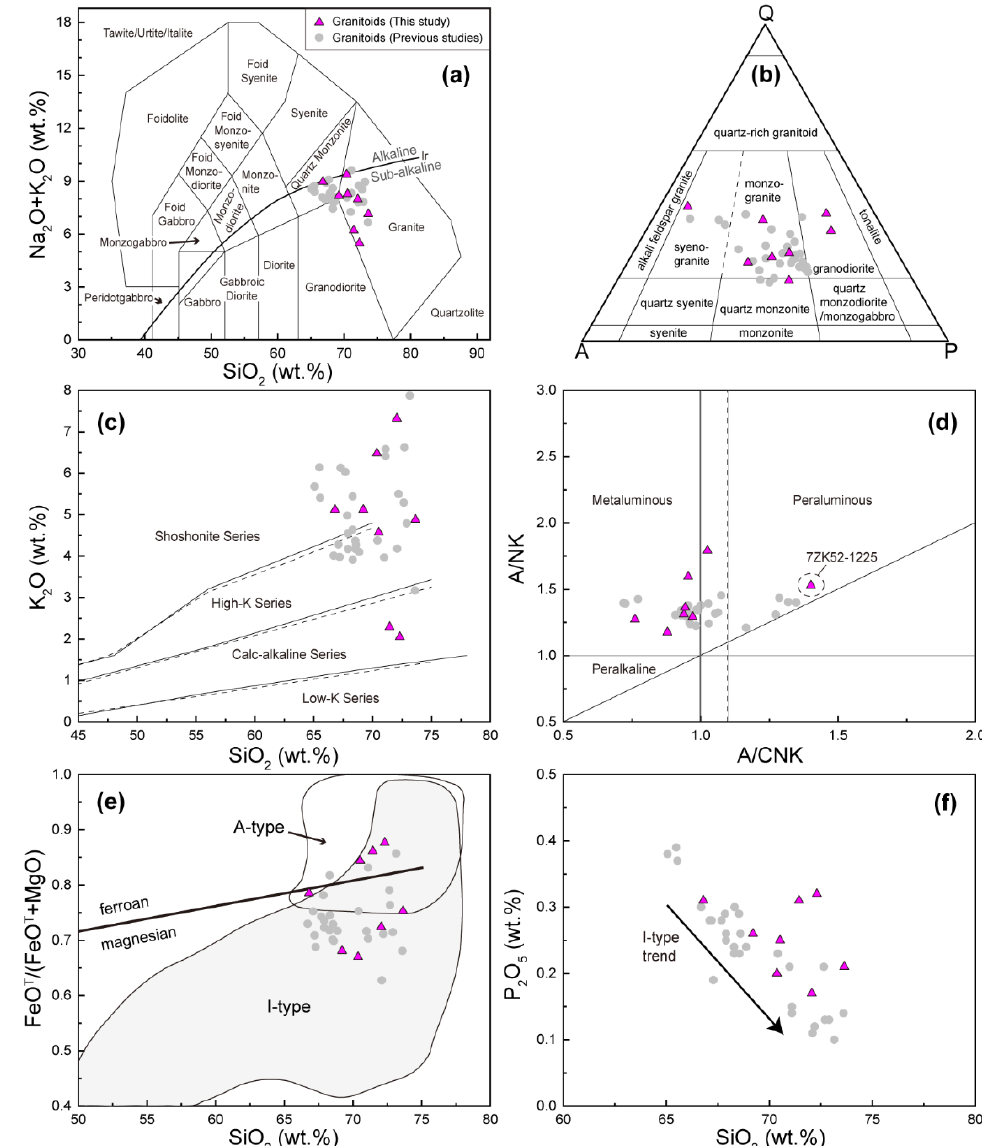
Figure 5. Compositional discrimination diagrams of the Hongniu Hongshan granitoids. ( a ) TAS diagram; ( b ) Q-A-P diagram; ( c ) K 2 O vs. SiO 2 diagram; and ( d ) A/NK vs. A/CNK diagram for classification of rock series. ( e ) FeO T /(FeO T + MgO) vs. SiO 2 diagram and ( f ) P 2 O 5 vs. SiO 2 diagram for classification of genetic types. Gray dots show the Hongniu-Hongshan granitoids reported by previous studies [13,15,17,39]. See Tables S1 and S4 in the Supplementary Materials for data in this figure. In the chondrite-normalized rare earth element (REE) diagram [40], these samples show significant enrichment of light rare earth elements (LREEs) compared with heavy rare earth elements (HREEs; Figure 6a) with LREE/HREE = 18.3 – 24.3 and (La/Yb) N = 28.6−58.3. A slightly negative abnormality of Eu is observed for all these rock samples with δEu = 0.54−0.89 (Figure 6a). Mostly, these samples exhibit relative depletion in Ba, Sr, P, and Ti, and enrichment in Rb, Th, U, Pb, Nd, Zr, and Hf (Figure 6b).